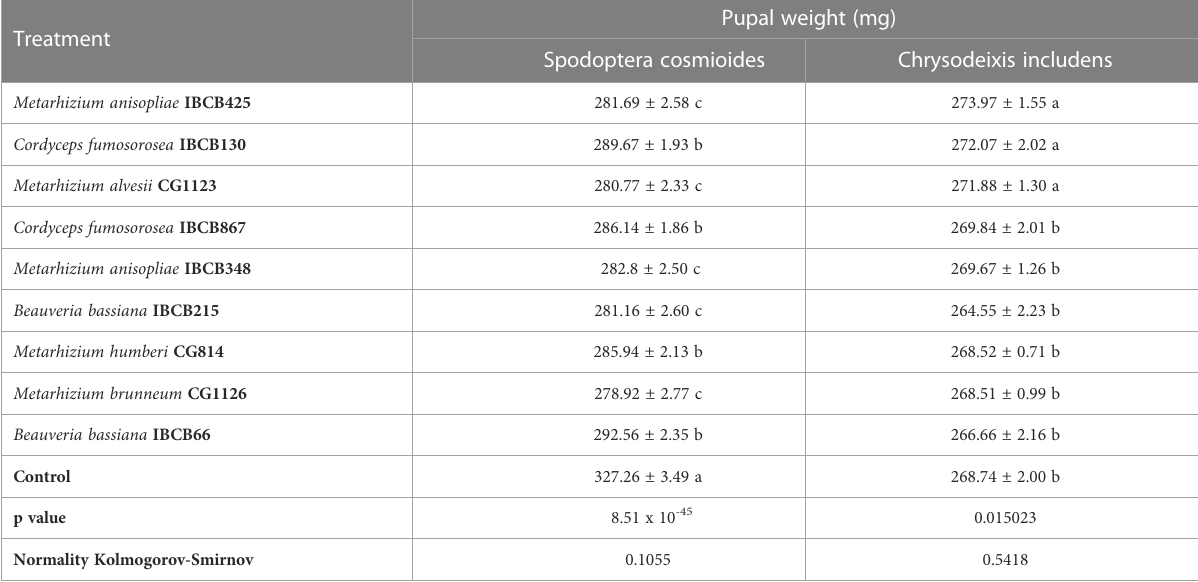
TABLE 3 S. cosmioides and C. includens pupal weights after feeding on peanut plants inoculated with entomopathogenic fungi and uninoculated control.